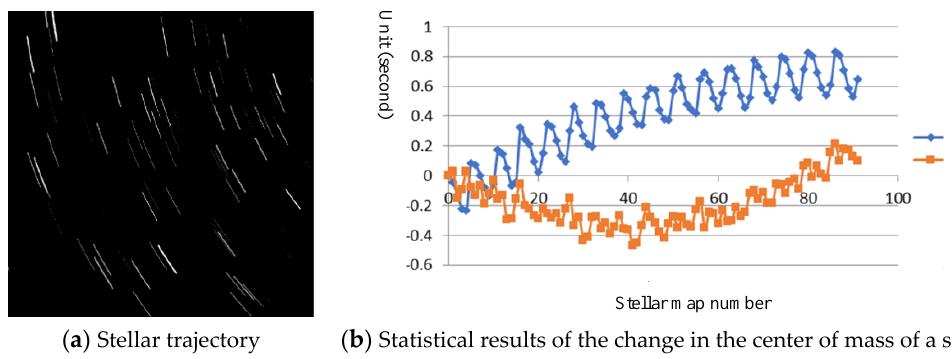
( c ) y-direction parallax change Figure 6. Multispectral image data analysis results. 3.1.2. Star-Based Microvibration Detection To facilitate the comparison, the experiment selected the ZY-3-01 orbit 000,381 stellar map, which was captured at the same time, to analyze the microvibration of the satellite platform. Figure 7a shows the stellar motion trajectory of the 000,381 orbital stellar map. The centroid extraction and trajectory fitting are performed on the stellar image points of the sequence star map. Figure 7b shows the statistical result of the difference between the statistical centroid coordinates and the